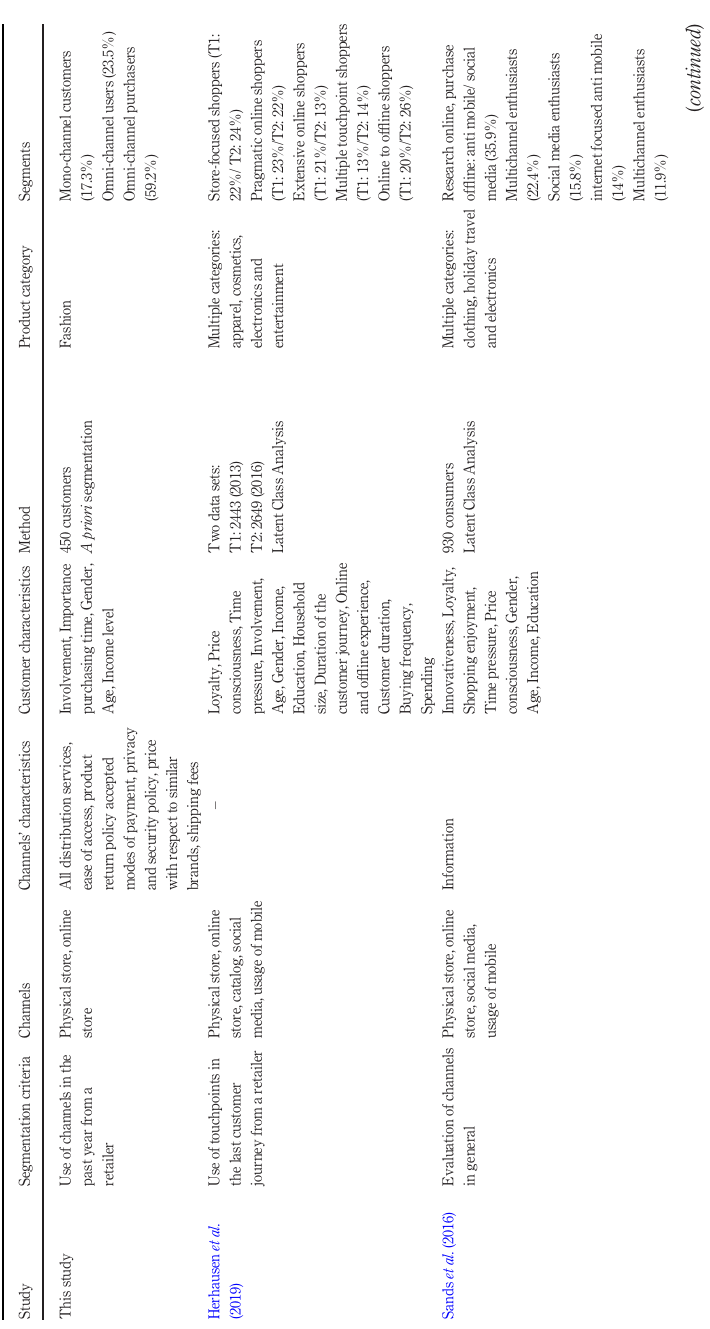
Table I. Segmentation studies of omni-channel